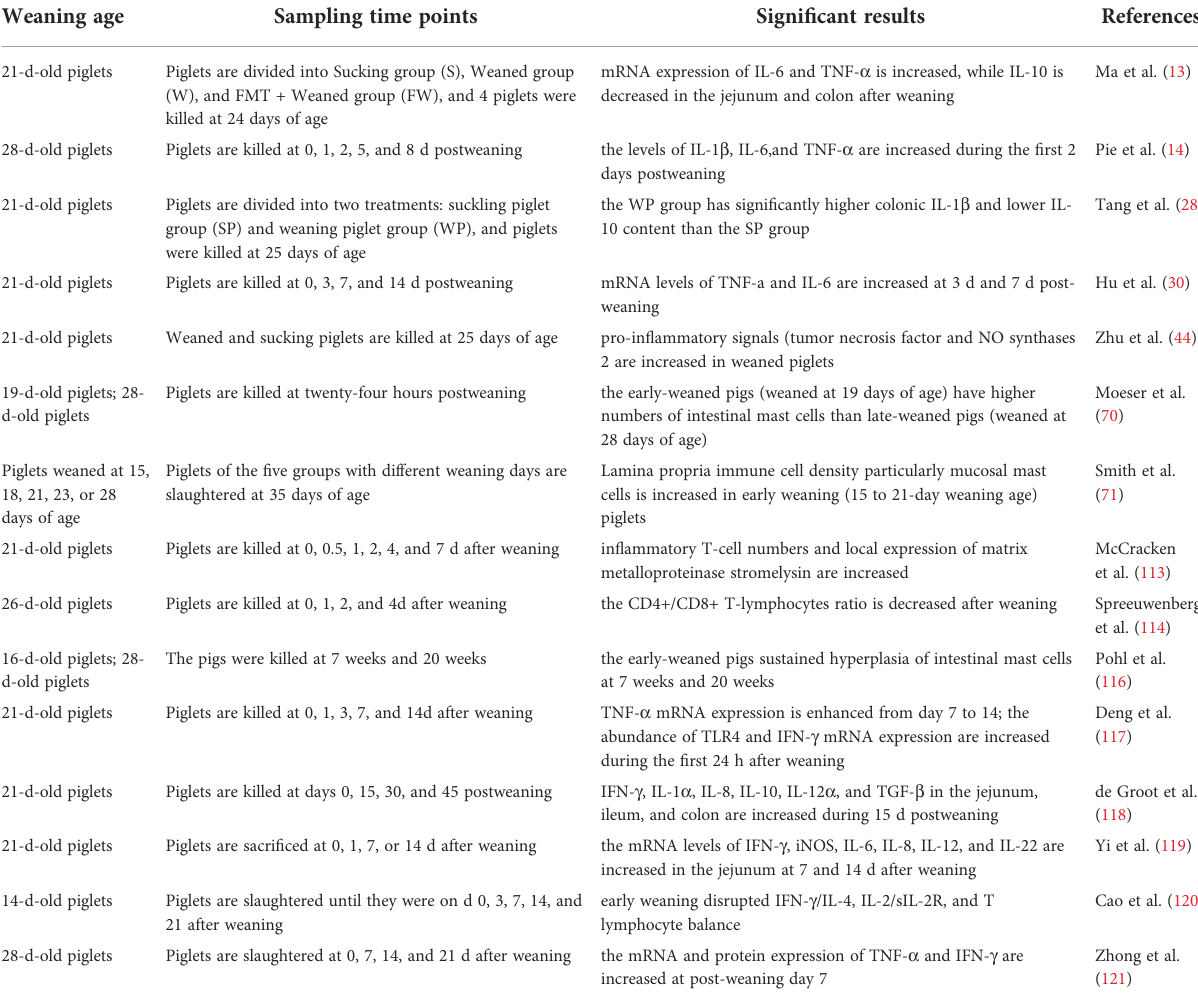
TABLE 2 A summary of the effects of weaning Stress on intestinal immune function in piglets. Weaning